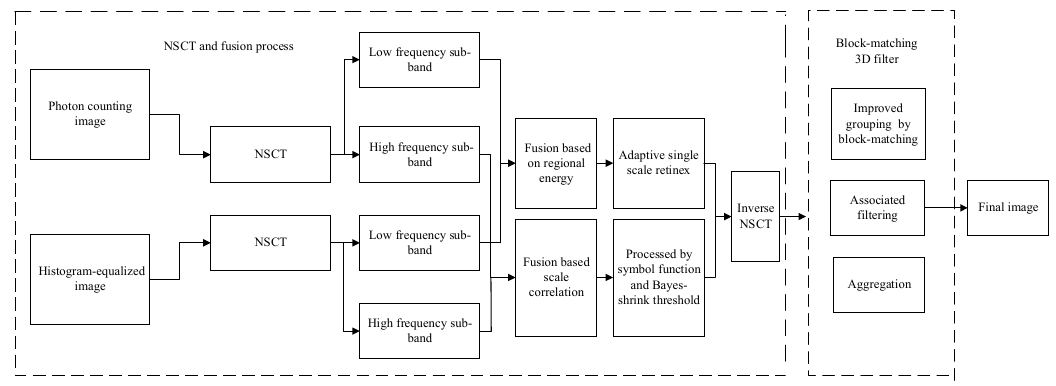
Figure 1. Overall framework presented in this paper.